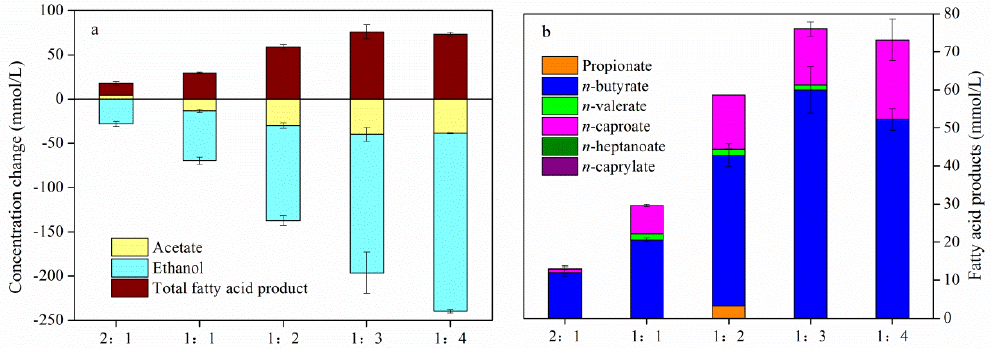
Figure 2. Substrate consumption (negative values) and product formation (positive values) ( a ), and fatty acid product distribution ( b ) with acetate as the electron acceptor at the maximum reaction degree.